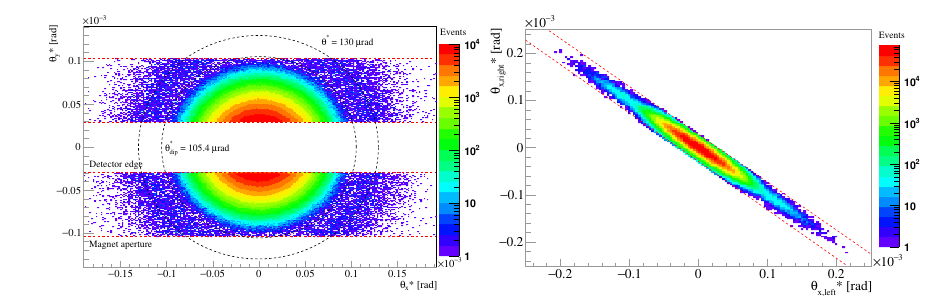
Figure 1. Left panel: Rotational symmetry of elastic scattering in the ( θ ∗ ,θ ∗ ) plane at √ s = 13 TeV y x proton-proton collisions, as measured by TOTEM and detailed in ref. [3]. The red dashed lines show the analysis acceptance cuts, which define the acceptance boundaries near the detector edge and magnet = 105 . 4 aperture. The inner black dashed circle illustrates the approximate scattering angle position θ ∗ dip µ rad of the di ff ractive minimum, while the outer black dashed line indicates the approximate scattering = 130 µ rad of the di ff ractive maximum. Right panel: Collinearity of the angle position of θ ∗ bump in elastic pp scattering at √ s = 13 and θ ∗ horizontal scattering angles at the collision point θ ∗ x , right x , left TeV proton-proton collisions, as reconstructed by TOTEM [3]. The dotted lines indicates 4 σ physics cuts applied to select the elastic events. See ref. [3] for the collinearity cuts on the vertical scattering angle θ ∗ as well as further details on the other analysis y